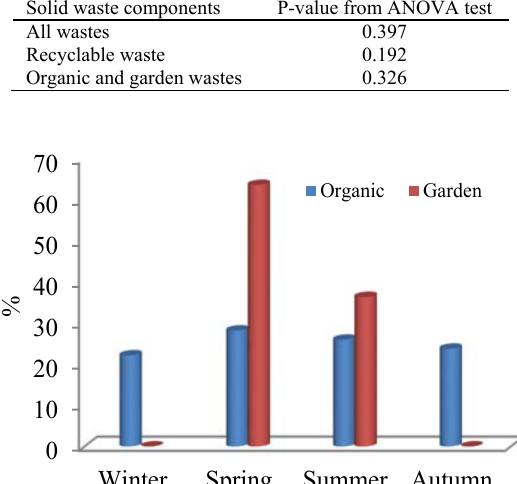
Table 3: The relationship between income and waste- P-value from ANOVA Test Solid waste components